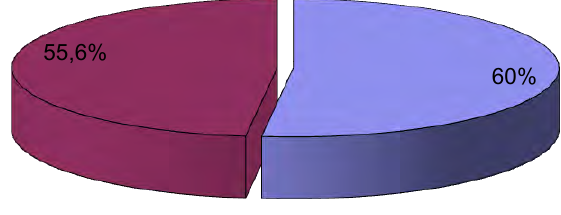
Fig. 7. Schoolchildren’s willingness to achieve an Olympic champion title